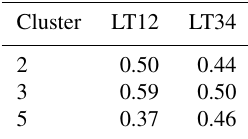
Table 4. Pearson correlation between the daily mean S component and the maximum daily rainfall for the three cluster